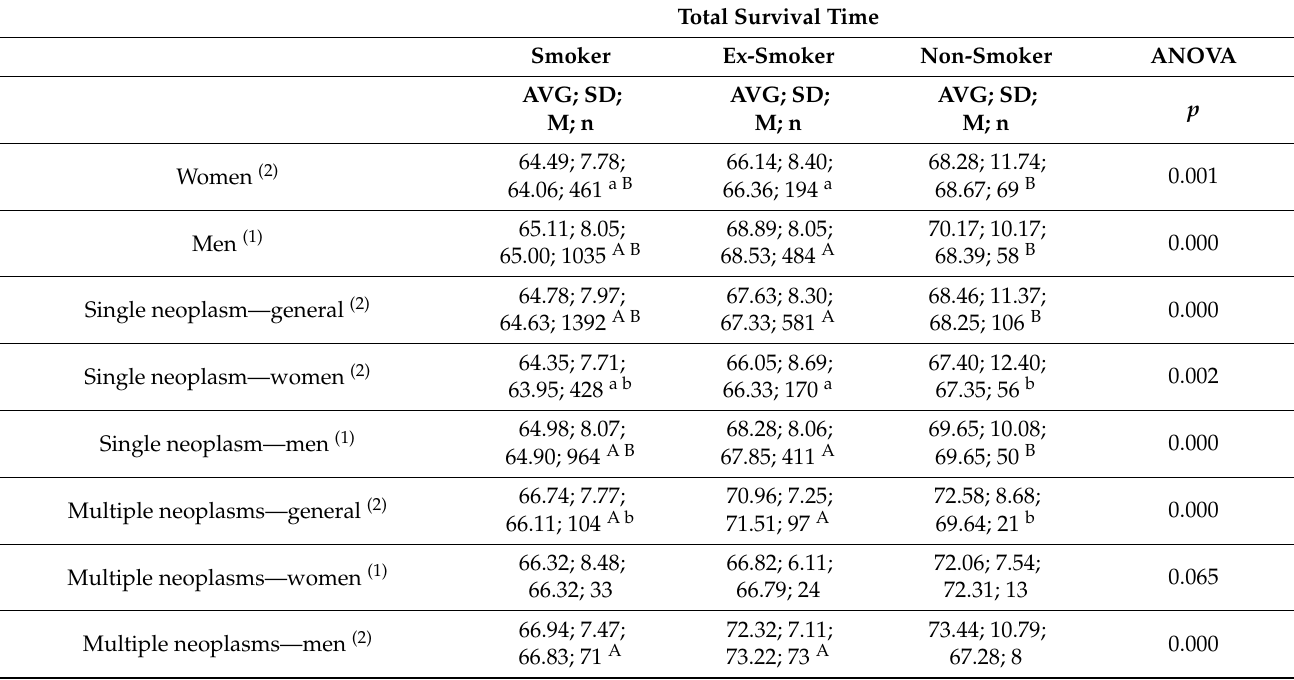
Figure 3. The Kaplan–Meier longevity in ex-smokers. Analysis of variance (ANOVA) showed statistically significant differences ( p < 0.05) in total survival time between groups of smokers, ex-smokers, and non-smokers, taking into consideration gender and single/multiple neoplasms. The results of the performed tests are shown in Table 3. Table 3. Total survival time comparison in consideration of tobacco intake—ANOVA and post-hoc tests results .